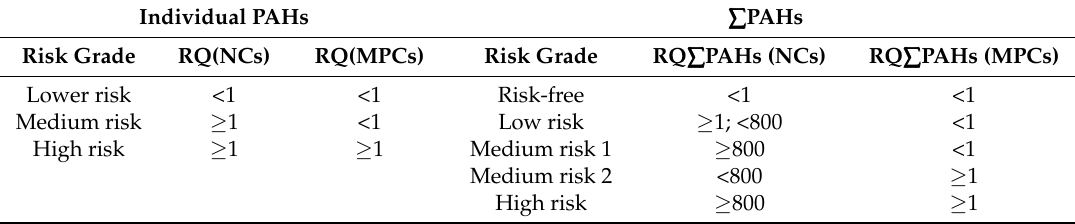
Table 1. The environmental quality values negligible concentration and maximum permissible concentration of polycyclic aromatic hydrocarbons